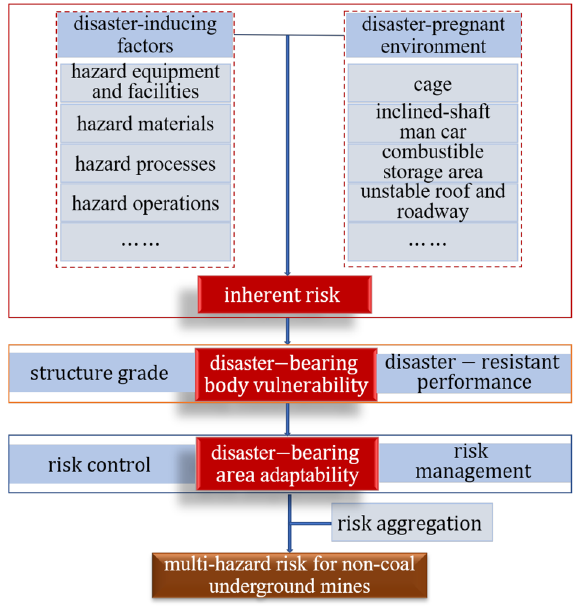
Figure 3. Risk assessment framework for multi-hazard sources in non-coal underground